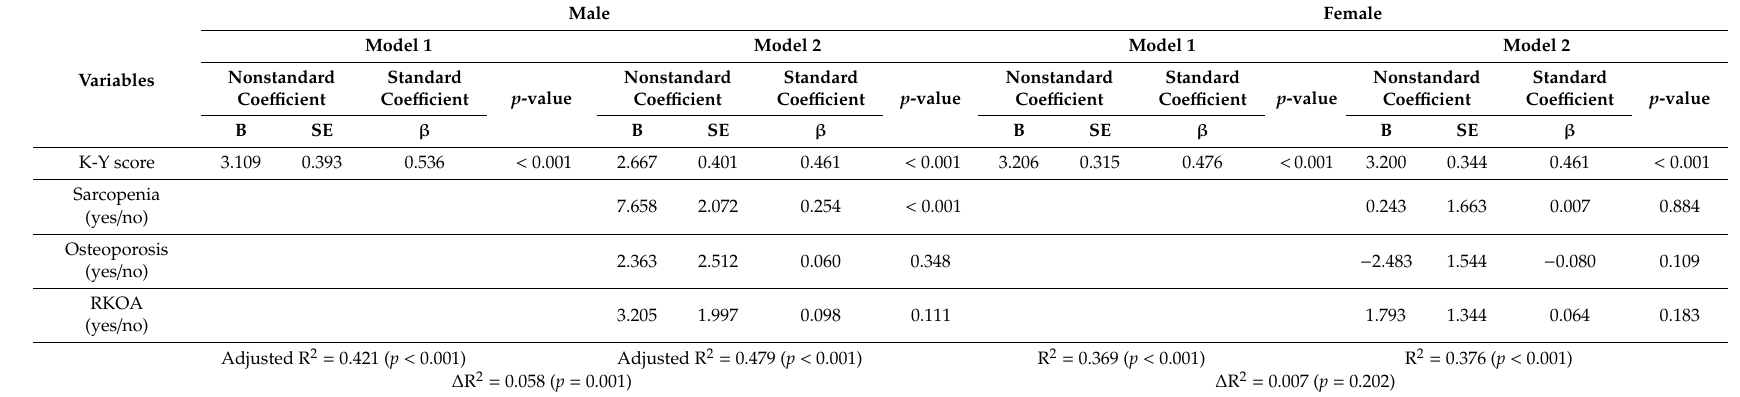
Table 2. Regression analysis for World Health Organization Disability Assessment Schedule 12